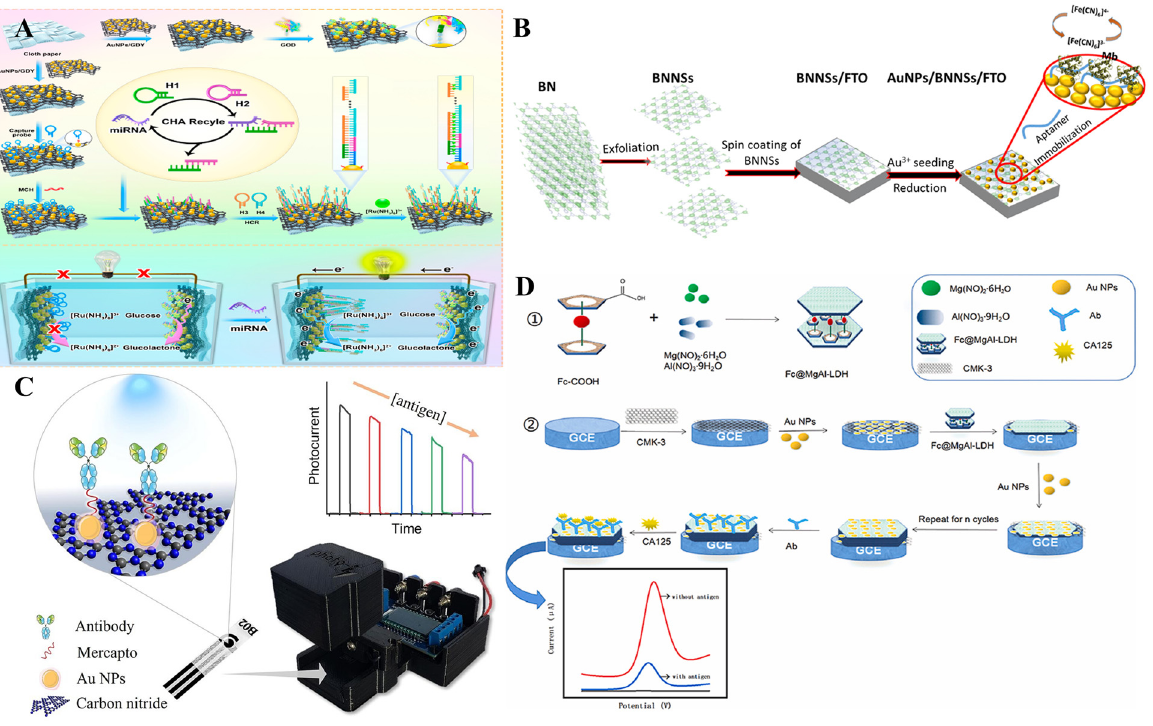
Figure 21. Schematic illustration of ( A ) Fabrication of a GDY-based self-powered device for miRNA- 21 detection. Reprinted with permission from Ref. [164]. Copyright 2021 ACS, ( B ) Fabrication of AuNPs decorated boron nitride nanosheets based label-free aptasensor for the detection of the cardiac biomarker myoglobin. Reprinted with permission from Ref. [165]. Copyright 2019 Elsevier, ( C ) Graphitic carbon nitride sensitized with AuNPs for the PEC detection of CA15-3. Reprinted